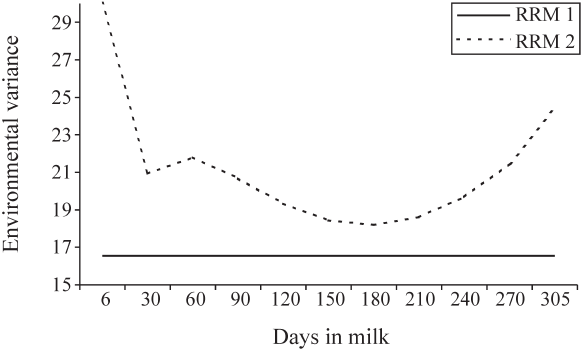
Figure 2 - Environmental variances (sum of permanent environmental and residual variances) during the different lactation periods estimated by the RRM1 and RRM2 random regression